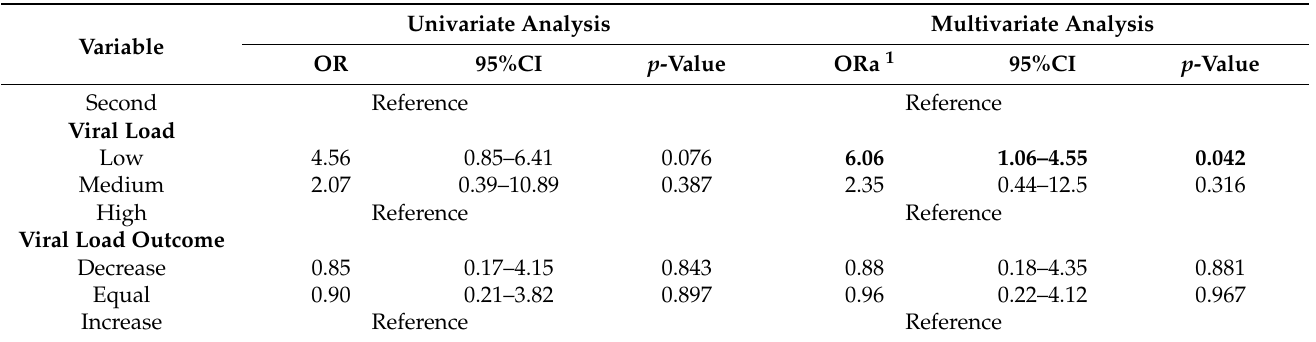
Table 2. Results of the logistic regression to determine the variables associated with the community state type (CST) III according to the evaluated